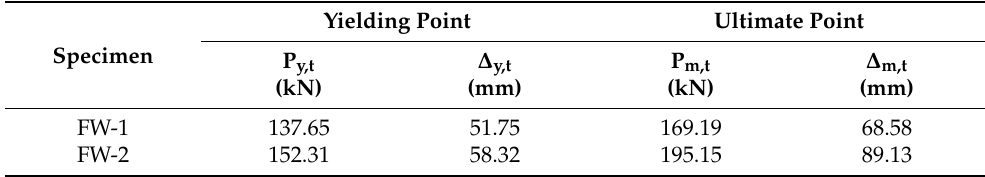
Table 3. Characteristic values on hysteresis curves.